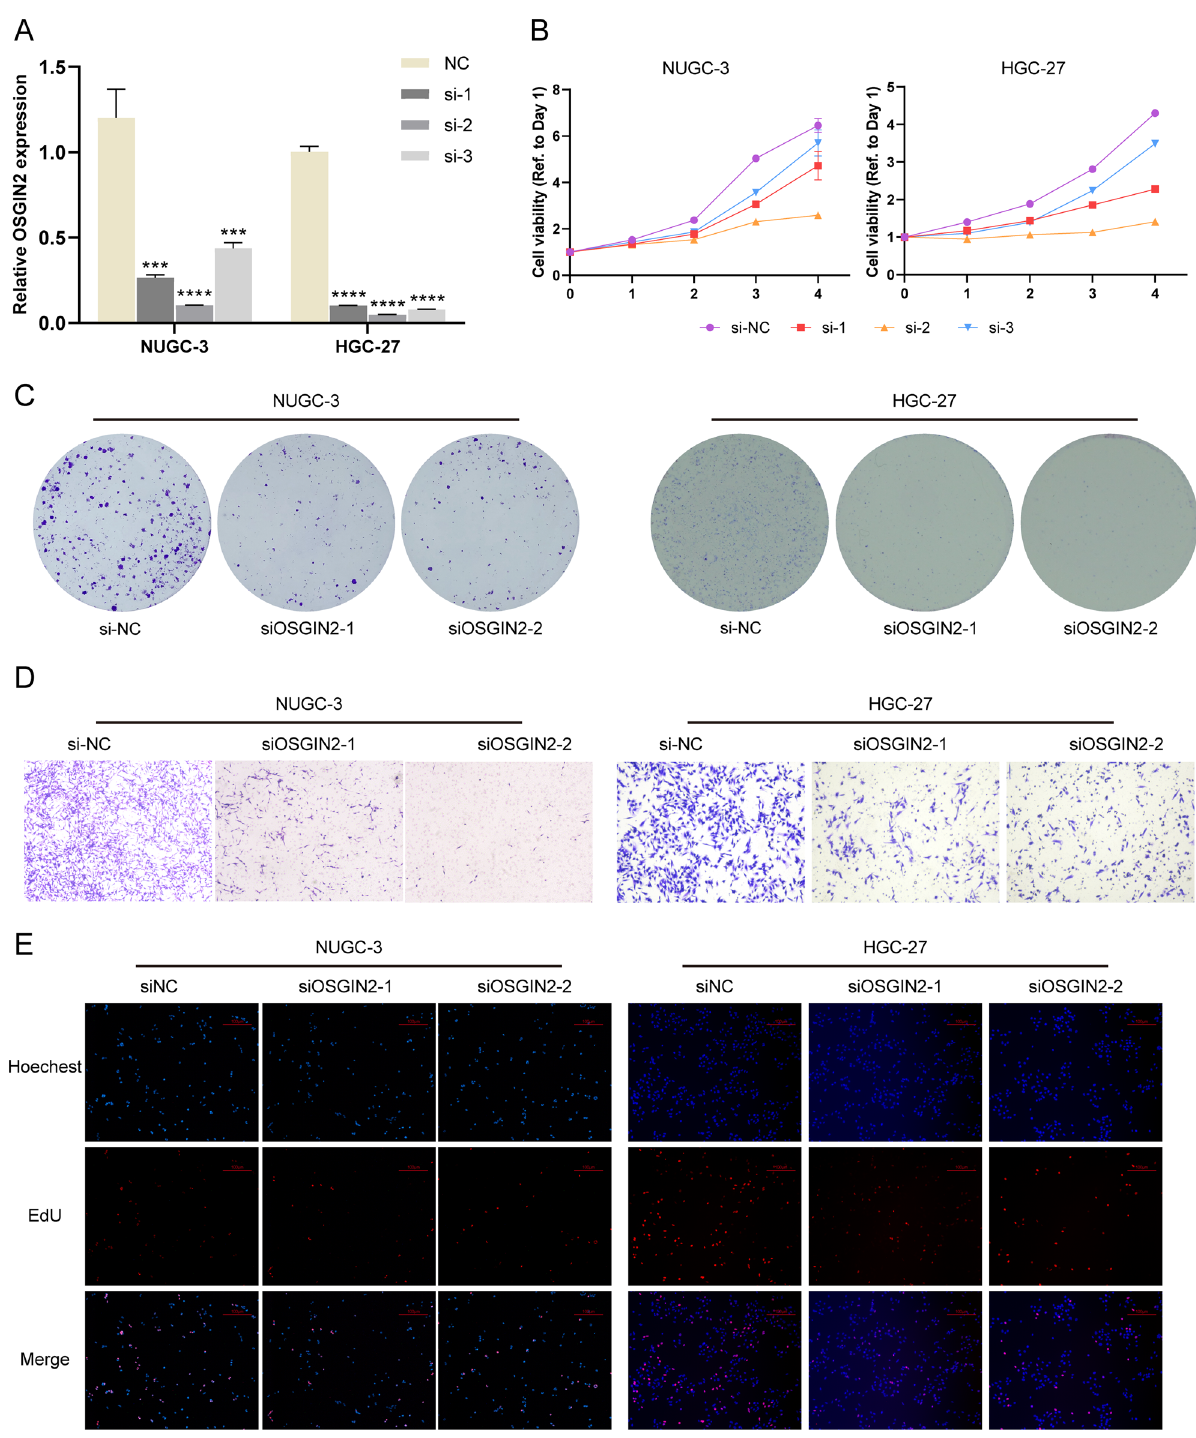
Figure 7. Functional verification of proliferation and migration of OSGIN2-knockdown NUGC3 and HGC27 cells ( A ) Transfection efficiency of OSGIN2 siRNA. (n = 3) ( B ) Cell proliferation ability of OSGIN2-knockdown cells, analyzed by CCK8 assays. (n = 3) ( C ) Colony formation ability of OSGIN2-knockdown cells. (n = 3) ( D ) Migration capacity of OSGIN2-knockdown cells. (n = 3) ( E ) Cellular DNA replication activity of OSGIN2- knockdown cells, detected by EdU experiment. (n = 3) ns p ≥ 0.05, * p < 0.05, ** p < 0.01, *** p < 0.001, **** p < 0.0001 vs si-NC